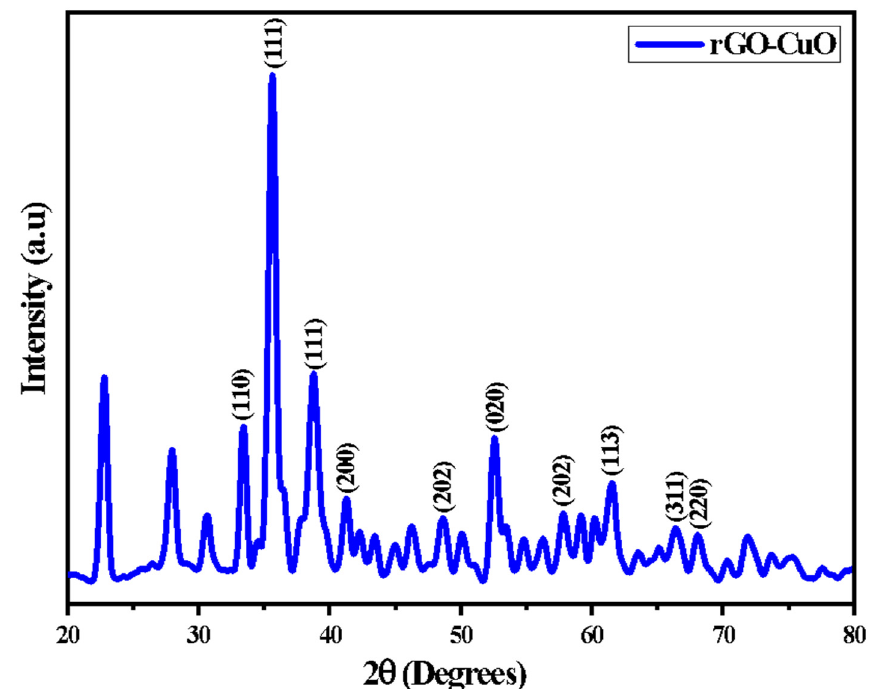
Figure 1. XRD pattern of as-synthesized rGO-CuO nanocomposites.